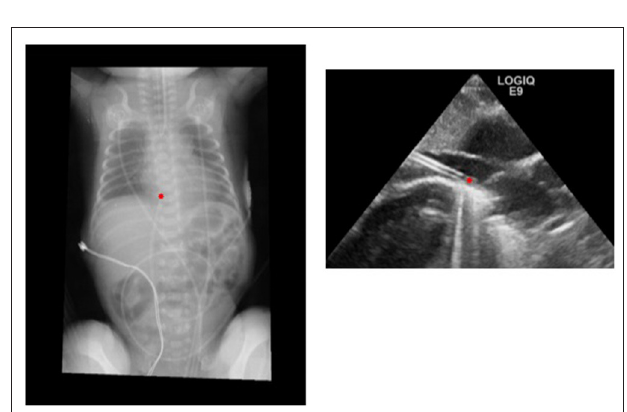
FIGURE 2 | Comparison of radiographic and ultrasound images of a correctly positioned